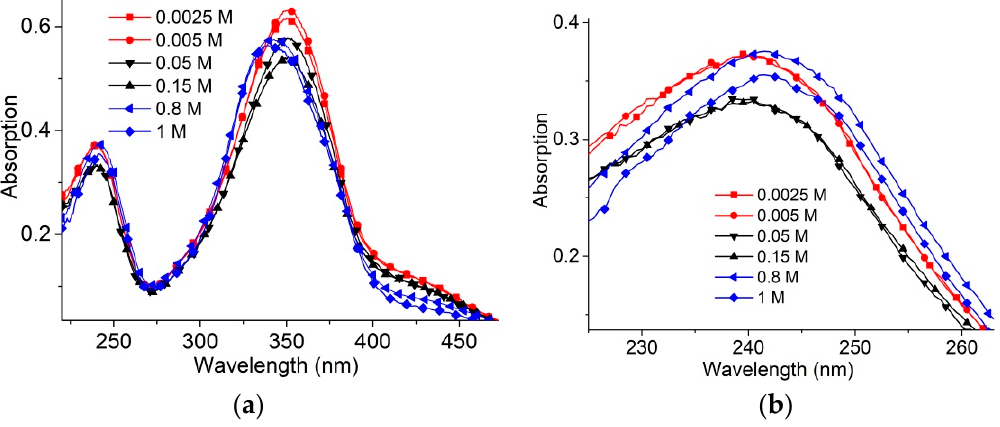
Figure 2. Surfactant absorbance spectra ( a ) at varied [NaCl] (as depicted) and zoomed-in short-wavelength band ( b ). [AzoTAB] = 8 × 10 − 6 M.